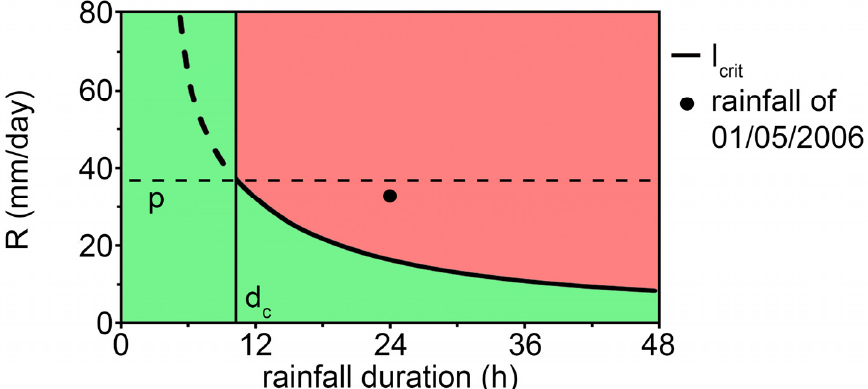
Figure 12. Comparison between the rainfall event recorded on 5 October 2005 and the critical curve calculated at the depth of 1.40 m.